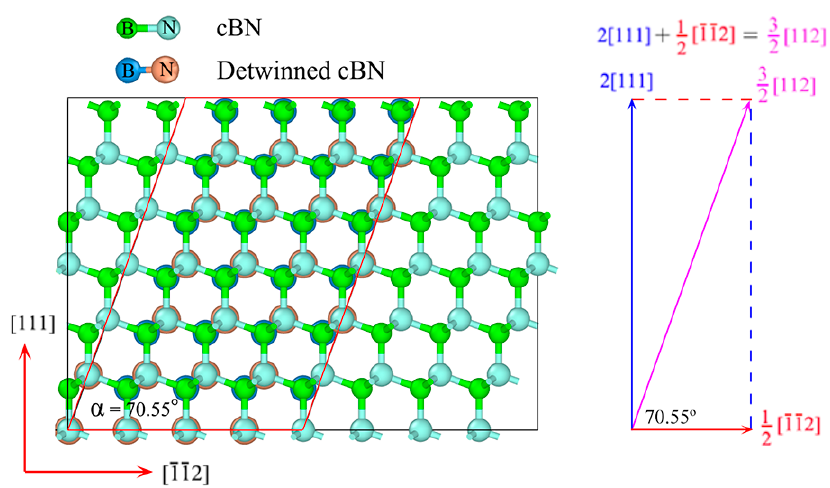
Figure 7. Comparison between atomic structure of relaxed cBN at zero stress and that of detwinned cBN after unloading.